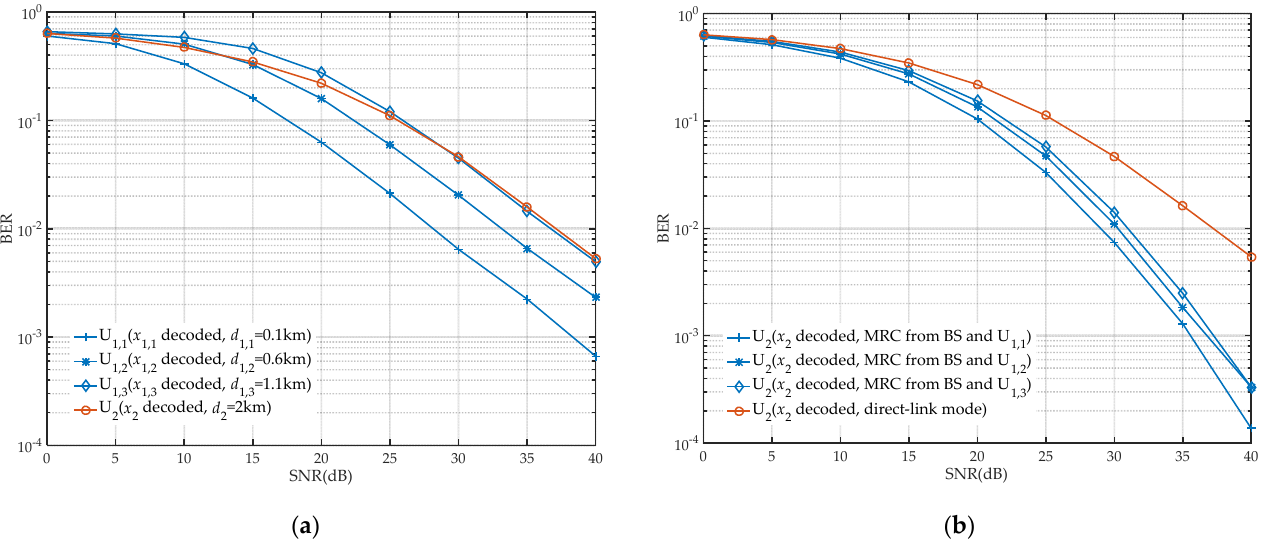
Figure 3. Decoding performance of users: ( a ) in direct-link mode ( P s = 1, a = 0.2); ( b ) in cooperative mode ( P s = 1, a = 0.2, 𝜌 = 0.6 ).